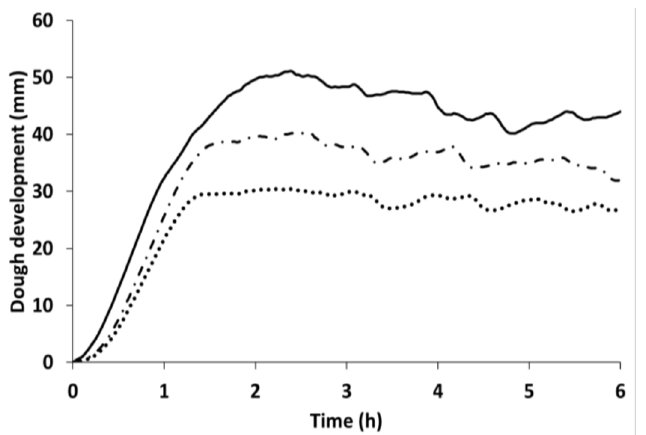
Figure 4. Dough-leavening properties of wheat (solid line), and with increasing replacement level of cricket powder (10%: dash–dotted line; 20%: dotted